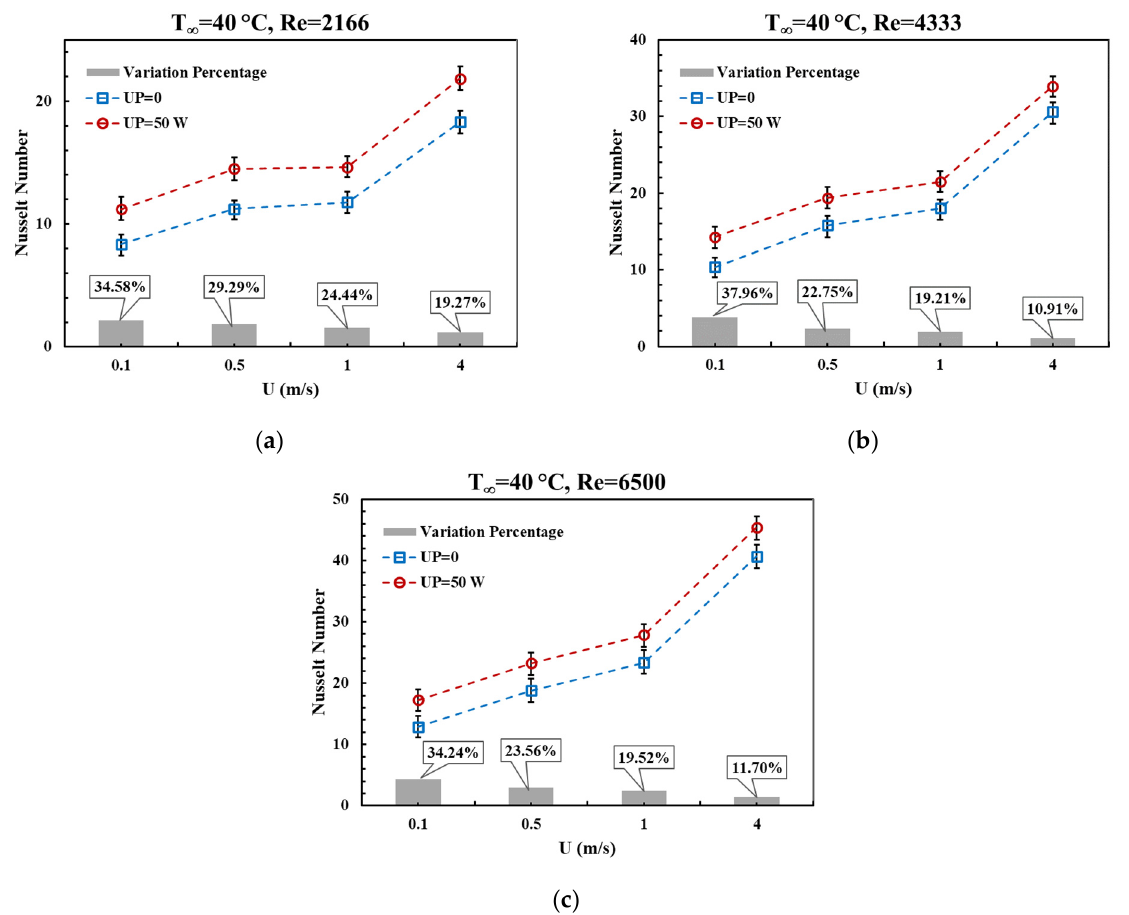
Figure 14. The variations of Nusselt number against U at T ∞ = 40 ( ◦ C ) and Reynolds numbers of ( a ) Re = 2166, ( b ) Re = 4333, and ( c ) Re = 6500. The results are presented in a no-vibration state (UP = 0) and in the presence of vibration with ultrasonic power of 50 Watts (UP = 50 (W)).